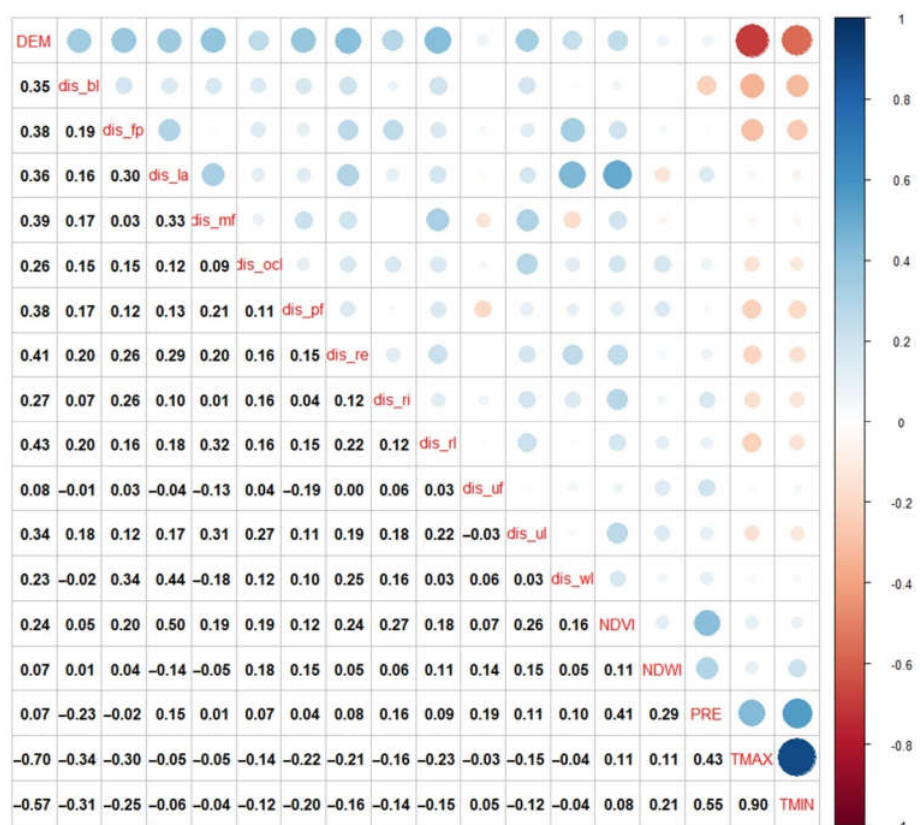
Figure A2. Correlation of 18 variables. (BL, bare land; DEM, altitude; FP, floodplains; LA, lake; MF, mudflat; NDVI, normalized difference vegetation index; NDWI, normalized difference water index; OCL, other construction land; PF, paddy field; PRE: monthly precipitation; RE, reservoir; RI, river; RL, rural land; TMAX, monthly mean maximum temperature; TMIN, monthly mean minimum temperature; UF, upland field; UL, urban land; WL, wetland). Red points represent negative correlations and blue points represent positive correlations.